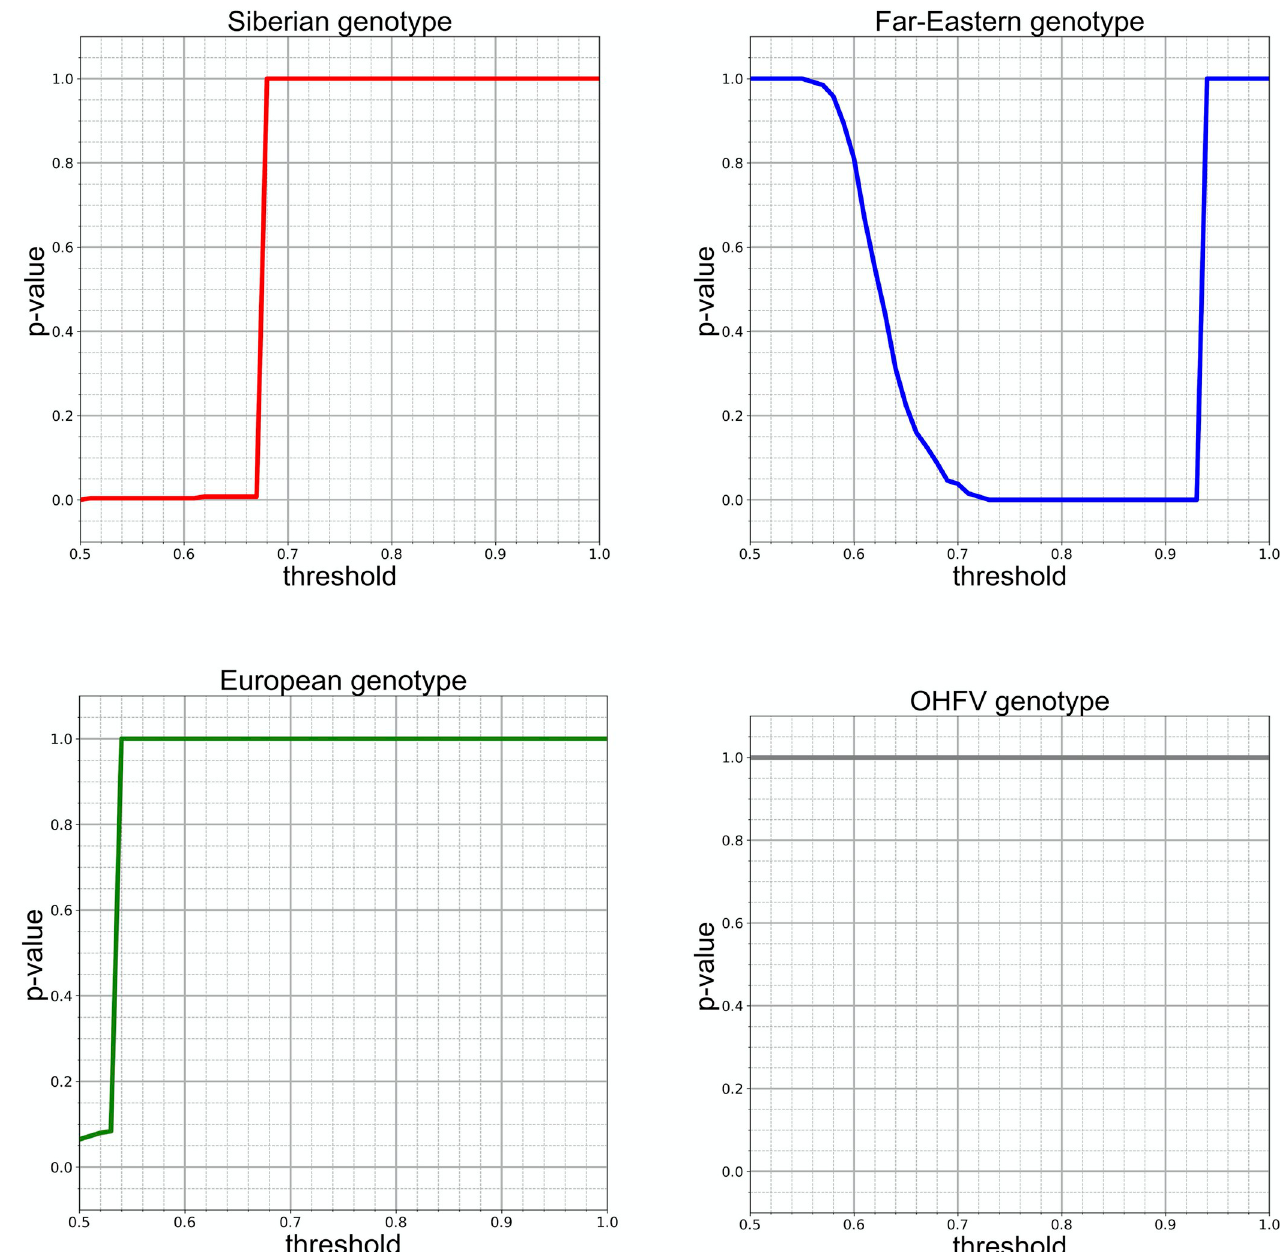
Fig 3. Phylogenetic evidence for recombinant origin of the Baikal subtype. The plots show the dependence of the p-value for the GSAUC statistic on the GS score threshold (with threshold increments of 0.01), relative to each of the four TBEV subtypes. While no GS score thresholds result in p < 0.05 for the European subtype and the OHFV (an outgroup species), for the Far-Eastern and Siberian subtypes, some of the GS score thresholds correspond to p < 0.05, indicating that both these subtypes contributed to the Baikal subtype. low p-value (down to 0.0) for threshold values up to ~0.67, corresponding to the elevated GS score in JCF2 (Fig 2D). The non-monotonic dependence of p-values on the threshold is unsur- prising: a p-value of 1 is expected both for low thresholds (as the baseline GS score is rather uniform across the genome) and for high thresholds (as the GS score never reaches values above ~0.95, Fig 2D). For the European subtype, the GS scores are somewhat elevated for low